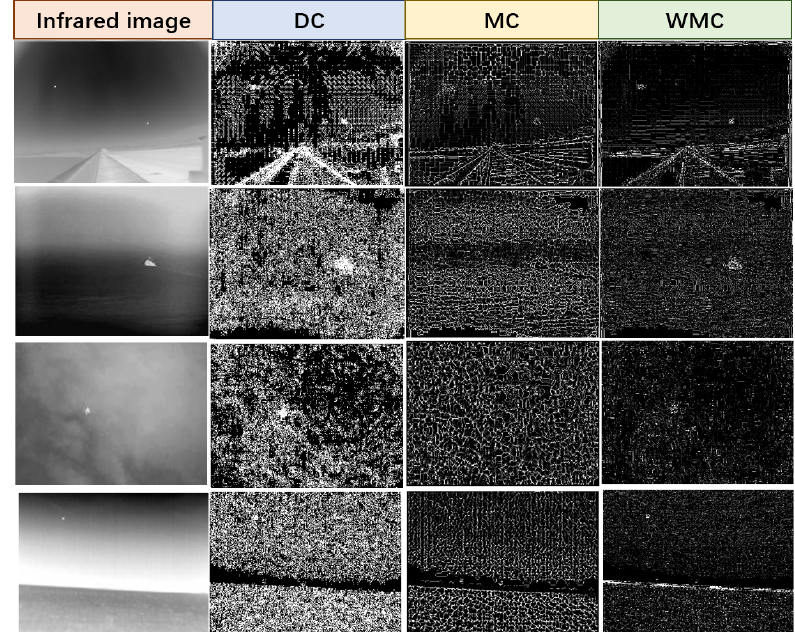
Figure 7. Visual results of different